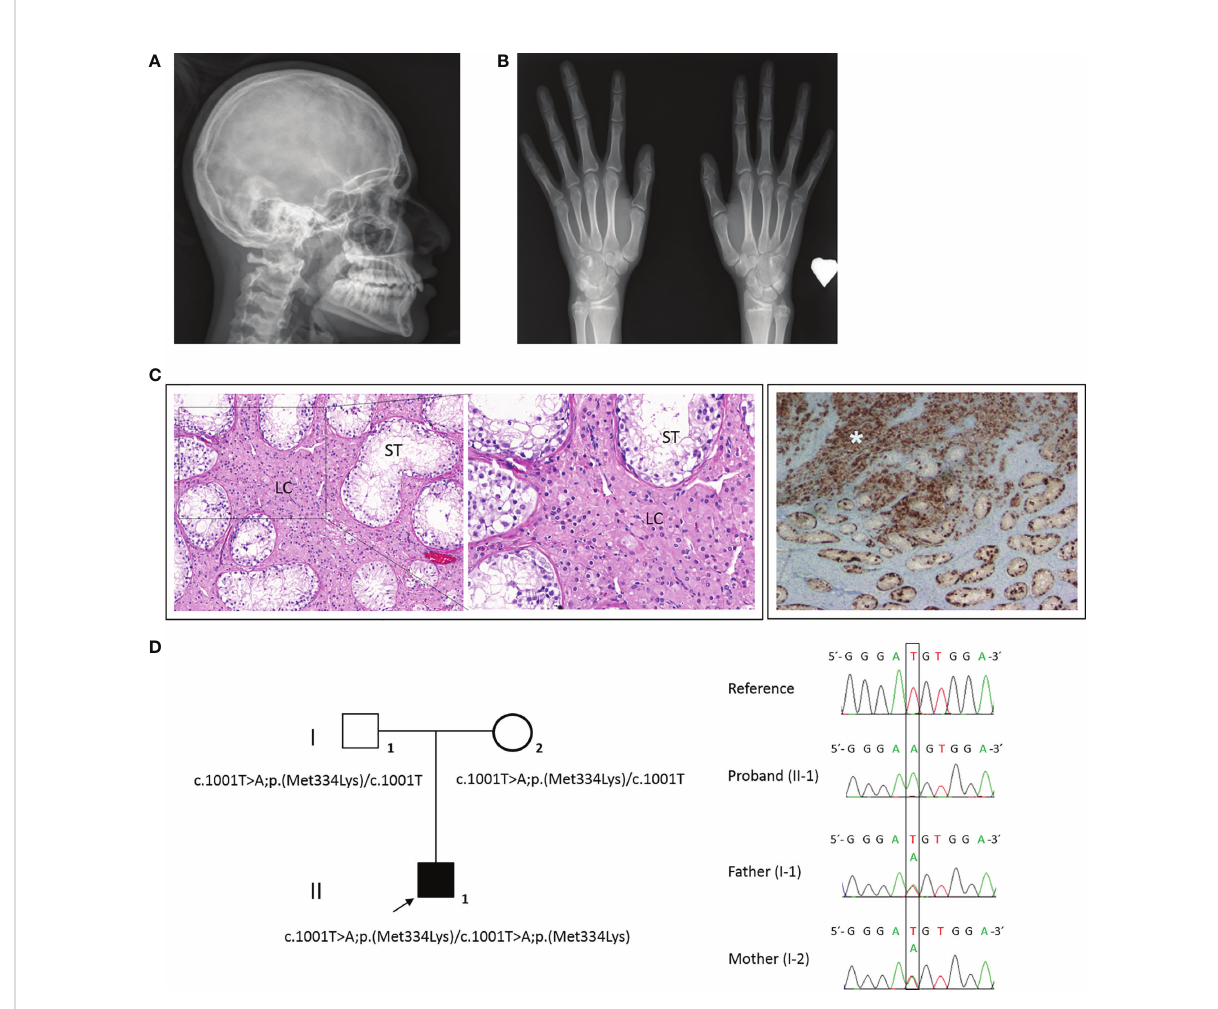
FIGURE 2 Physical examination, clinical signs, and HHAT candidate variant in our 46,XY patient. (A) Microcephaly visible in X-rays. (B) Skeletal survey showed hypoplasia of distal phalanges of both thumbs and bilateral capito-hamate coalition. (C) The anatomopathological analysis of the right and left dysgenetic gonads showed immature seminiferous tubules (ST) with hyperplasia of Leydig cells (LC) (left and magni fi ed image) and a germ-cell (positive for placental alkaline phosphatase (PLAP) staining) tumor in the right gonad (asterisk) (right). (D) Family pedigree (right) and electropherogram (left) showing the proband (II-1, arrow) and parental (I-1 and I-2) genomic DNA with a T>A substitution observed in the 1001 position of HHAT gene (NM_018194). Both parents were